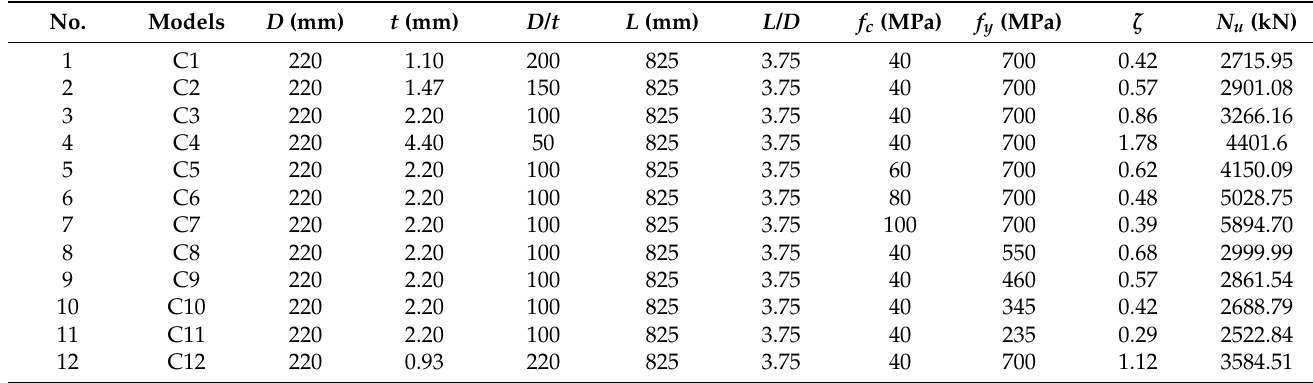
Table 5. Parameters of numerical